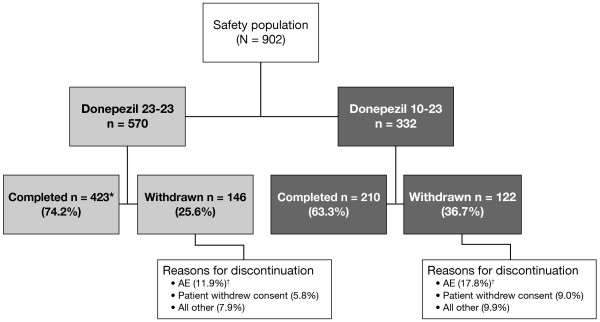
Subject disposition. *The completion status for one patient was not determined. †Includes all treatment emergent and treatment non-emergent AEs and SAEs.